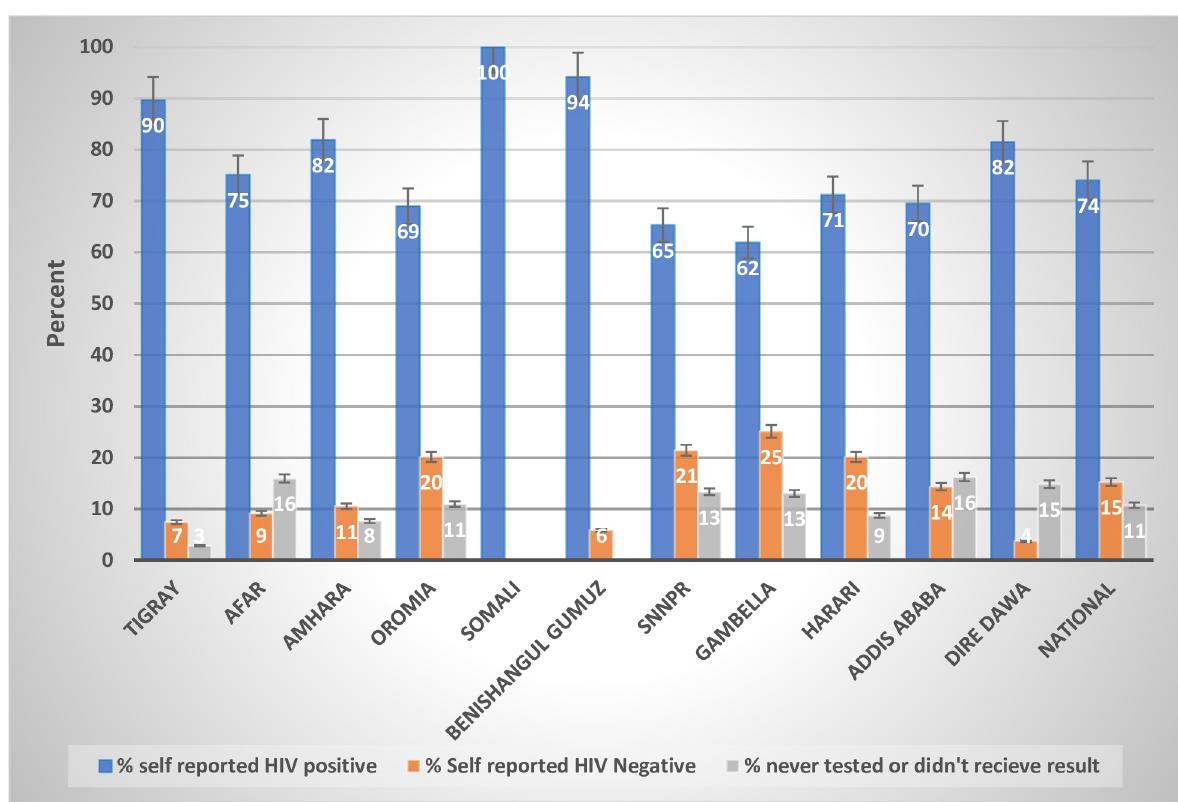
Fig 2. HIV-positive status by history among HIV-positive participants aged 15–64 years in urban Ethiopia, EPHIA 2017–2018. Table 3 provides the results of a log binomial regression analysis. Some demographic and behavioral factors were independently associated with higher probability of unawareness.